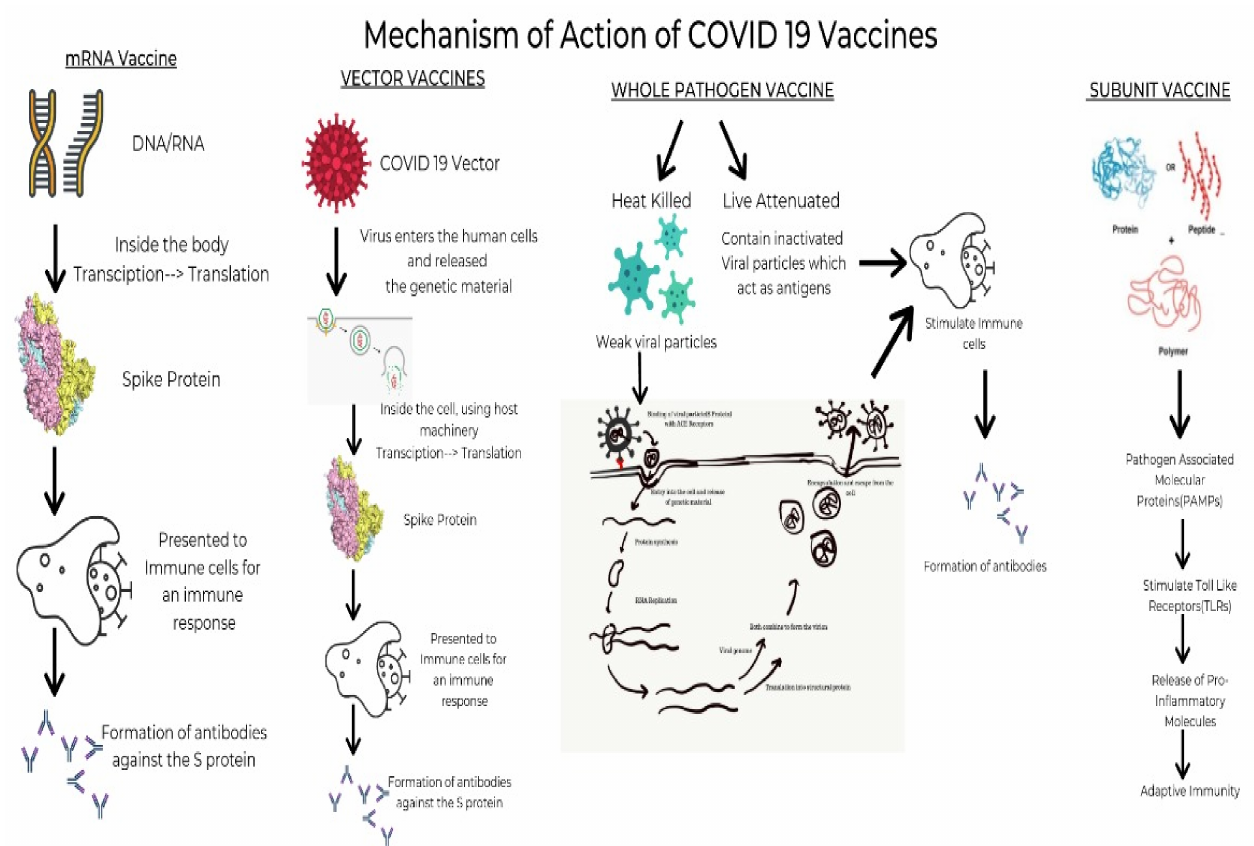
Figure 2. The mechanism of action of various types of